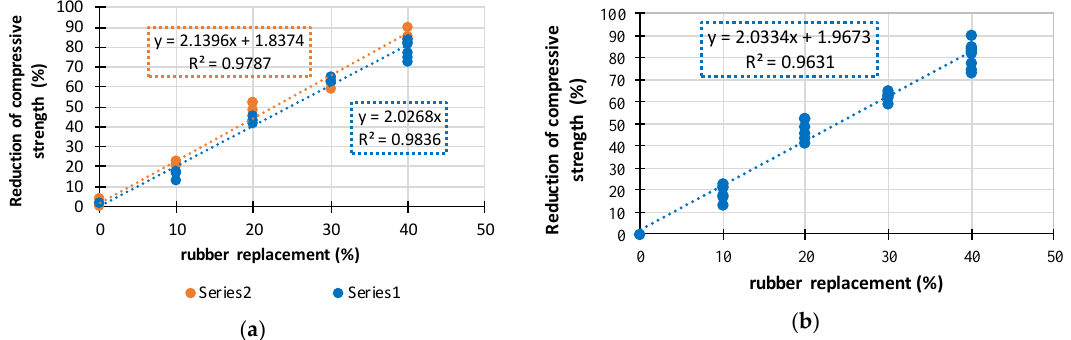
Figure 7. ( a ) Reduction of compressive strength depending on the cement amount; ( b ) reduction of compressive strength depending on the crumb rubber content. Table 5. Compressive strength, elastic modulus and stress-strain test results.